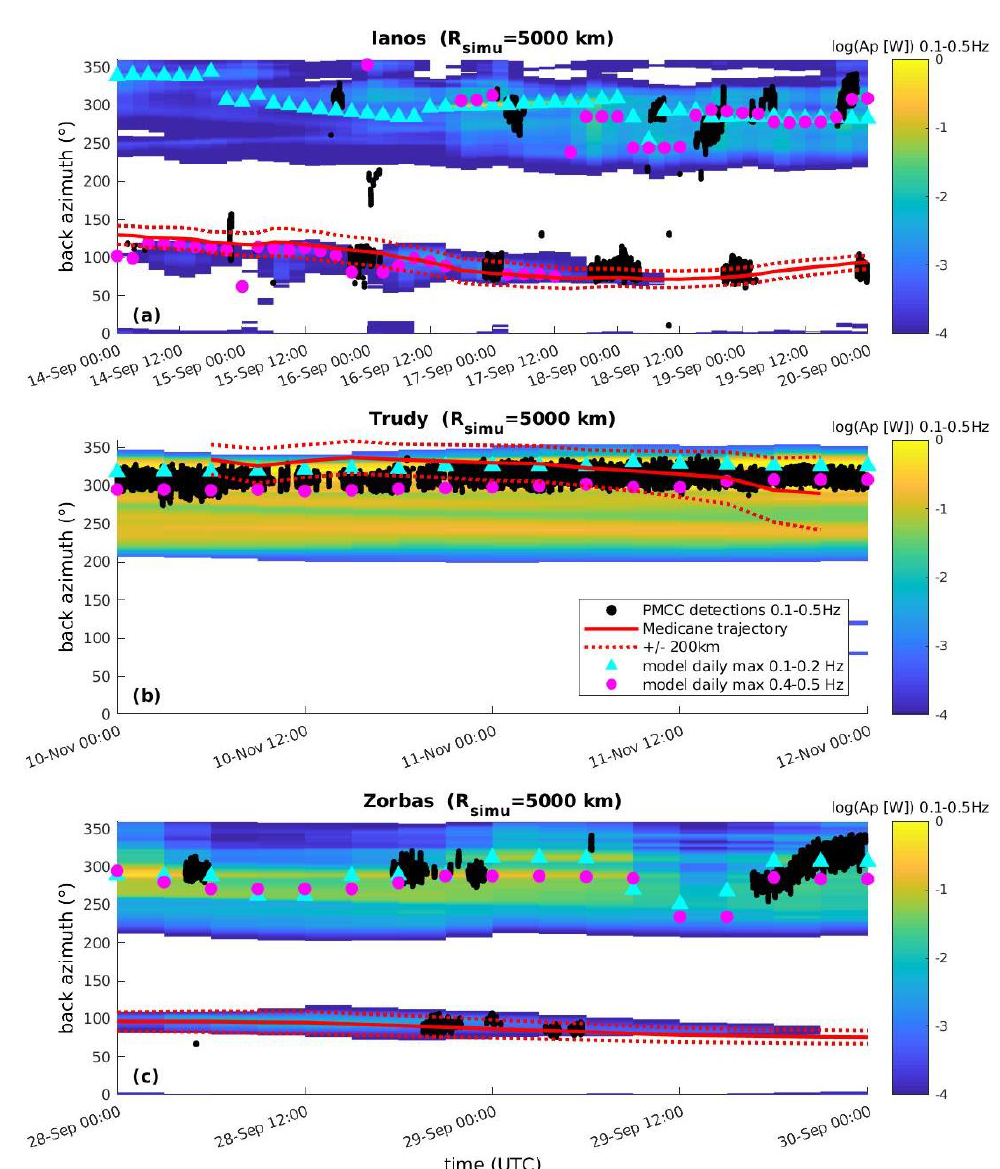
Figure 19. Same as Figure 18 but for detection simulations performed for sources within a distance of 5000 km from the station IS48.